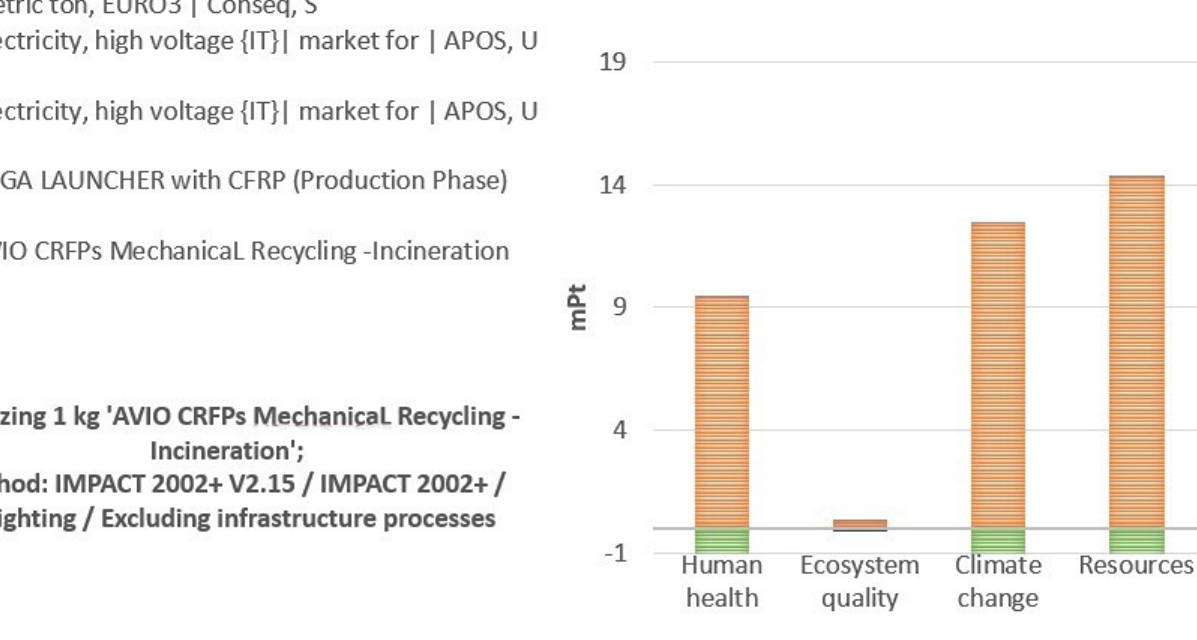
Figure 16. Results of Mechanical recycling with incineration into Endpoint categories.